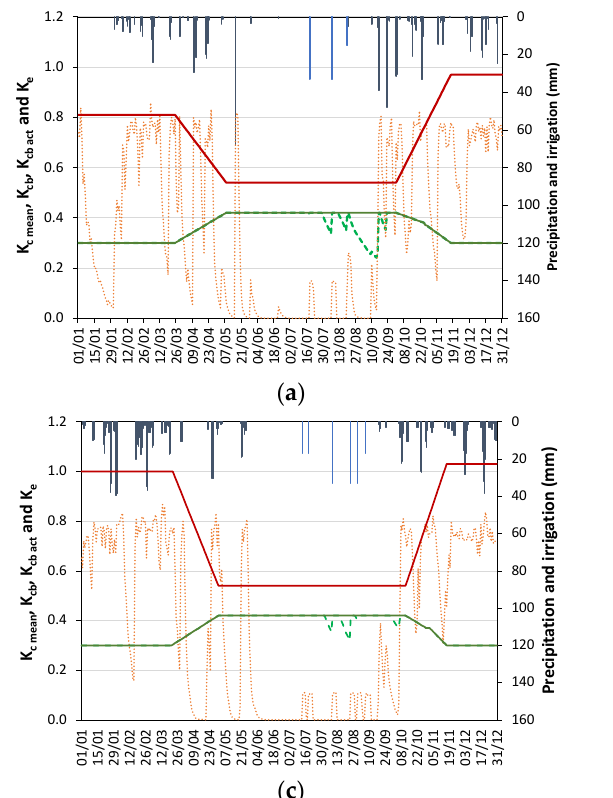
b 0 —regression coefficient, R 2 —coefficient of determination, PBIAS—percent bias, RMSE—root mean square error, AAE— average absolute error, EF—efficiency of modeling.